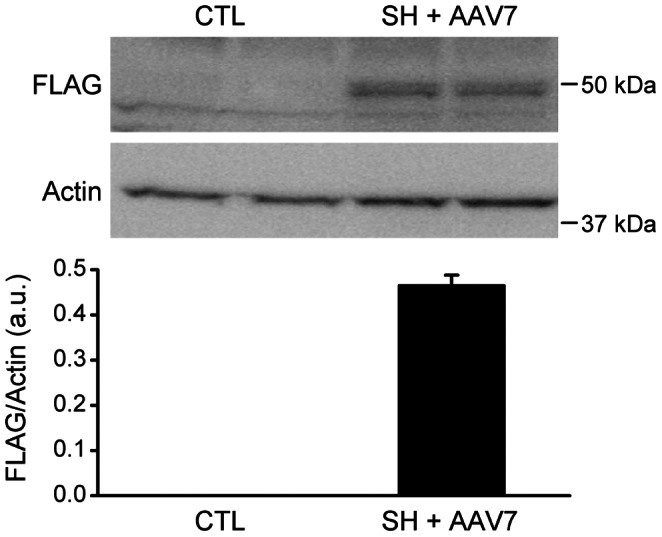
Retrograde delivery of intrapleural AAV7-TrkB.FL-FLAG to phrenic motoneurons, detected by FLAG expression in ventral horn.The cervical ventral horn region containing phrenic motoneurons was isolated and analyzed by Western blotting. Top: representative Western blot of FLAG (∼49 kDa) and actin (∼42 kDa) protein expression in the cervical ventral horn region from animals with C2 spinal cord hemisection (SH) performed at 3 weeks after intrapleural AAV7-TrkB.FL-FLAG treatment (SH+AAV7; n = 3). This is compared to that of control rats with no treatment or SH (CTL; n = 3). Bottom: relative expression (mean ± SE) of FLAG compared to actin. Western blot run in duplicate, left and right sides of each animal evaluated independently (bilateral AAV injection).